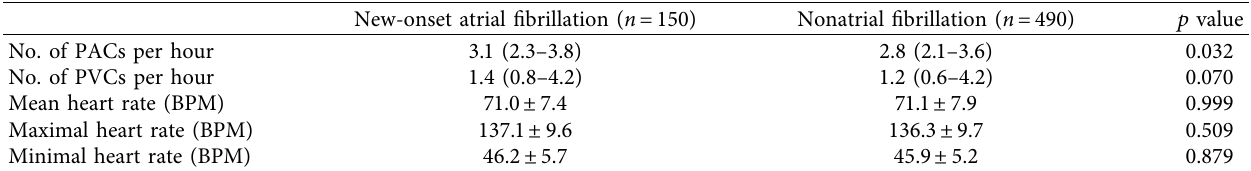
Table 4: 24-hour Holter findings.